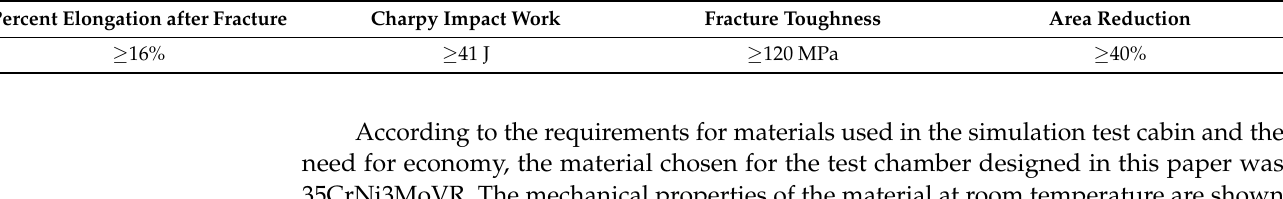
Table 2. Material property speci fi cations for ultrahigh-pressure vessels.